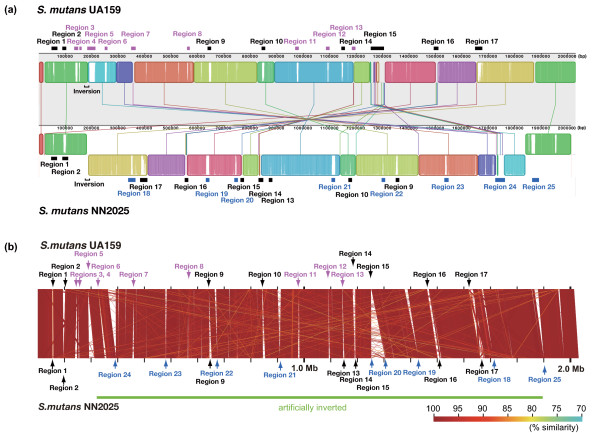
Local collinear blocks (LCBs) between chromosomal sequences of the two strains of Streptococcus mutans. (a) Representation of the whole 32 local collinear blocks (LCBs) between chromosomal sequences of the two strains of Streptococcus mutans, UA159 and NN2025, was generated by MAUVE software at a minimum weight of 411. The S. mutans UA159 DNA sequence given on the forward strand is the reference against which the sequence of the NN2205 was aligned and compared. LCBs placed under the vertical bars represent the reverse complement of the reference DNA sequence. The 32 connecting lines between genomes identify the locations of each orthologous LCB in the two genomes. Unmatched regions within an LCB indicate the presence of strain-specific sequence. Each sequential block represents homologous backbone DNA sequence without rearrangements. Black horizontal bars indicate rearrangement regions and strain-specific regions analyzed in detail (see additional files 2 and 3). Blue region numbers and bars indicate NN2025-specific regions, pink region numbers and bars indicate UA159-specific regions, and black region numbers and bars indicate variable regions. Distributions of regions 1–25 are analyzed by long-PCR in 97 S. mutans strains including strains NN2025 and UA159 (see additional files 4 and 6). A dot plot to compare genome structure of these strains is also shown in Figure 6. (b) Alignment of the two genomes is generated by artificially correcting for the inversion of NN2025 at the rrn-comX region by the PROmer of MUMmer software and GenomeMatcher software (green bar). Similarity is shown by color code as represented in this figure. Blue region numbers and arrows indicate NN2025-specific regions, pink region numbers and arrows indicate UA159-specific regions, and black region numbers and arrows indicate variable regions.